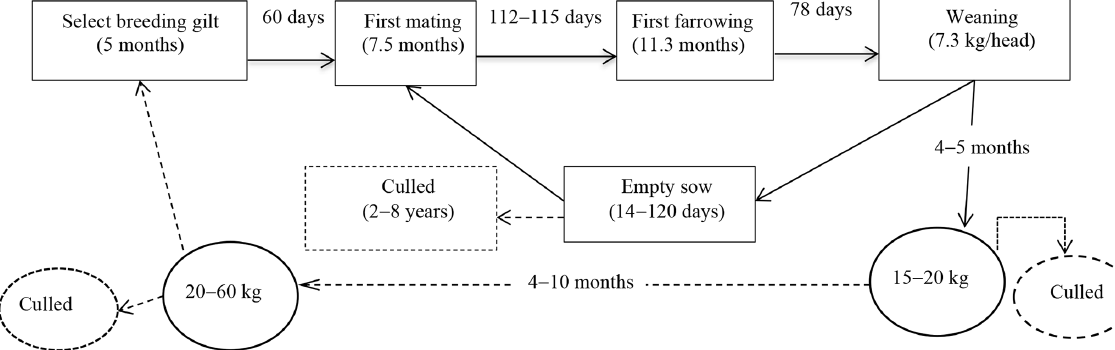
Pig housing, nutrition condition, and proper selection of